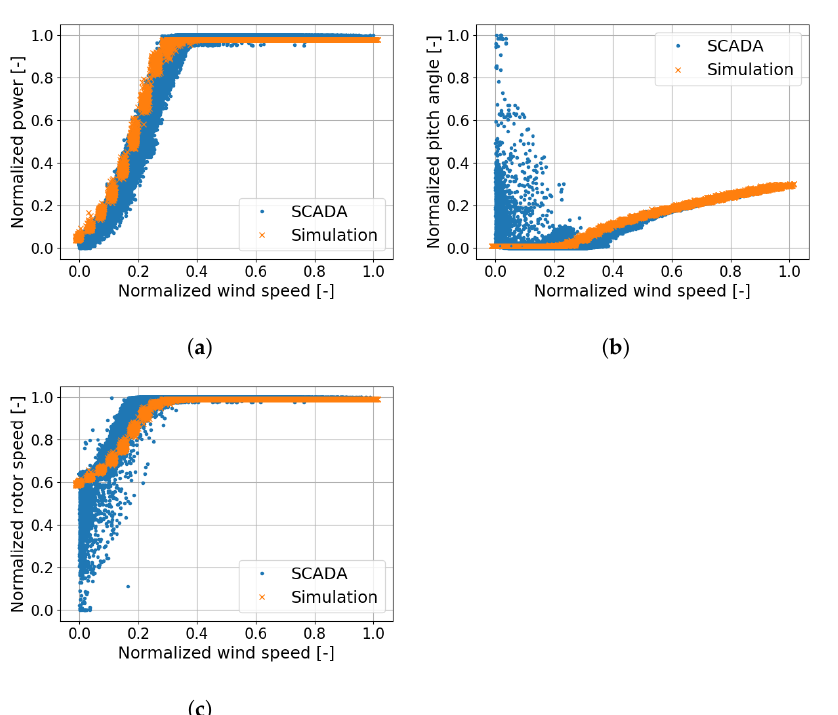
Figure 7. Comparison of measured and simulated data used for building a normal behavior model including ( a ) power, ( b ) pitch angle and ( c ) rotor speed with respect to the wind